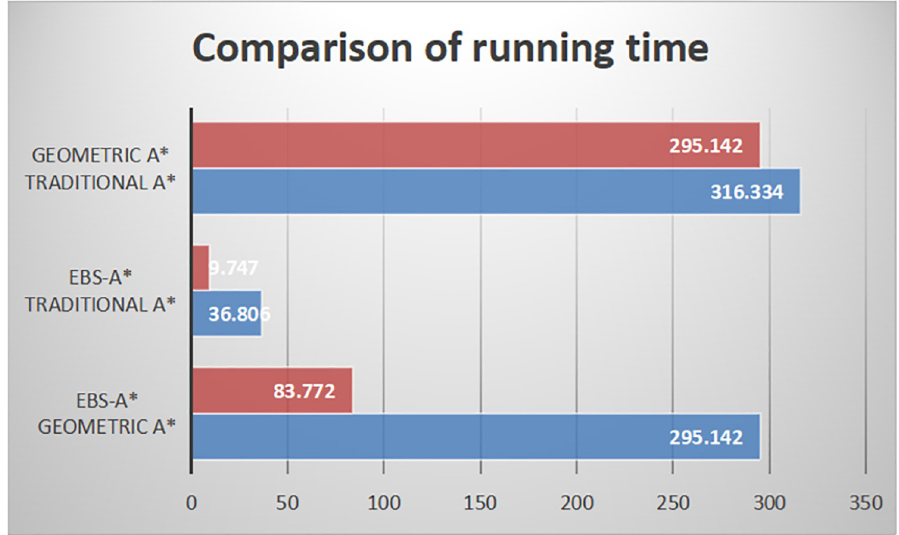
Fig 13. Comparison graph of algorithm running